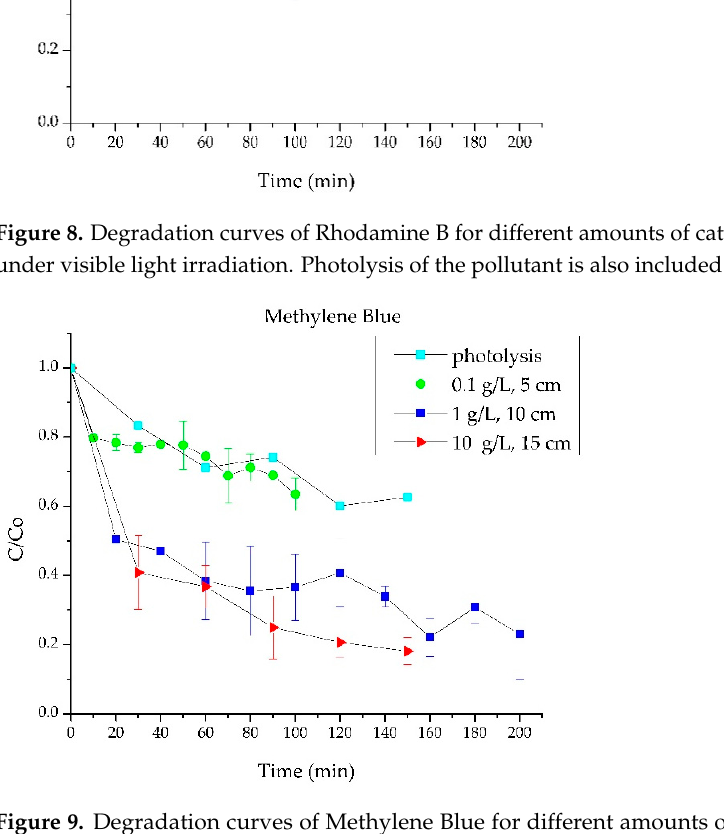
Figure 9. Degradation curves of Methylene Blue for different amounts of catalyst and irradiation time, under visible light irradiation. Photolysis of the pollutant is also included.